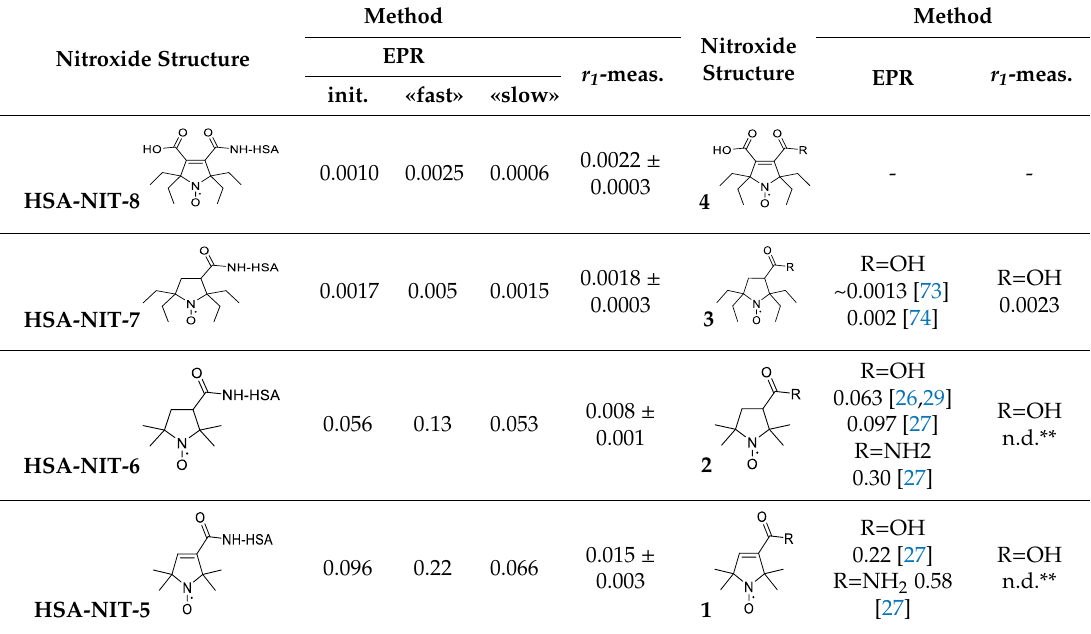
Table 3. Second-order rate constants *, k (M −1 s −1 ) for initial rates of reduction of nitroxides with ascorbate/glutathione solution in pH 7.4 at 25 ° C.